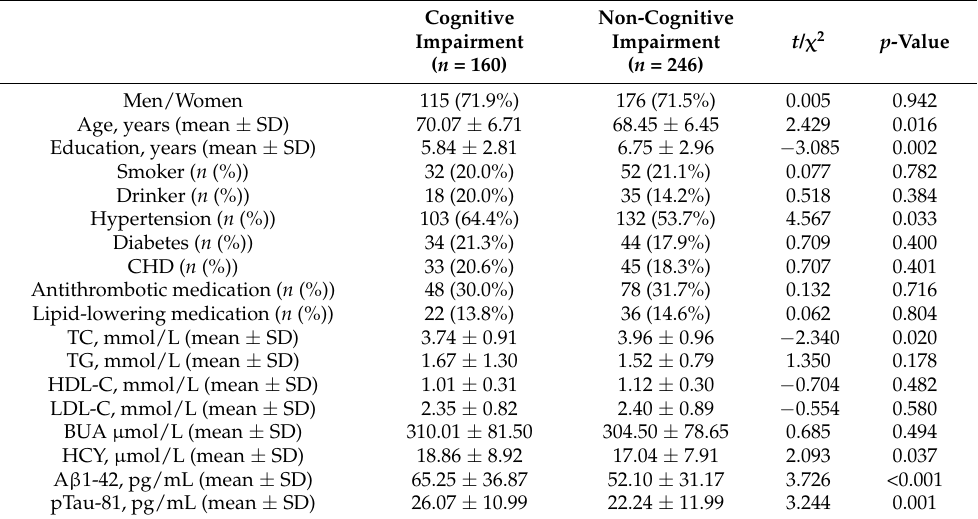
Table 5. Characteristics of the study population grouped according to the presence and absence of cognitive impairment.